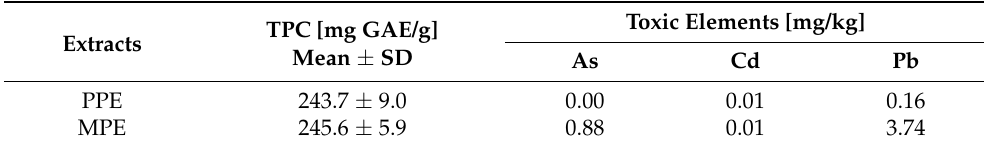
Table 4. Total phenolic content and toxic elements concentration of ethanolic extract from Poland (PPE) and New Zealand (MPE)